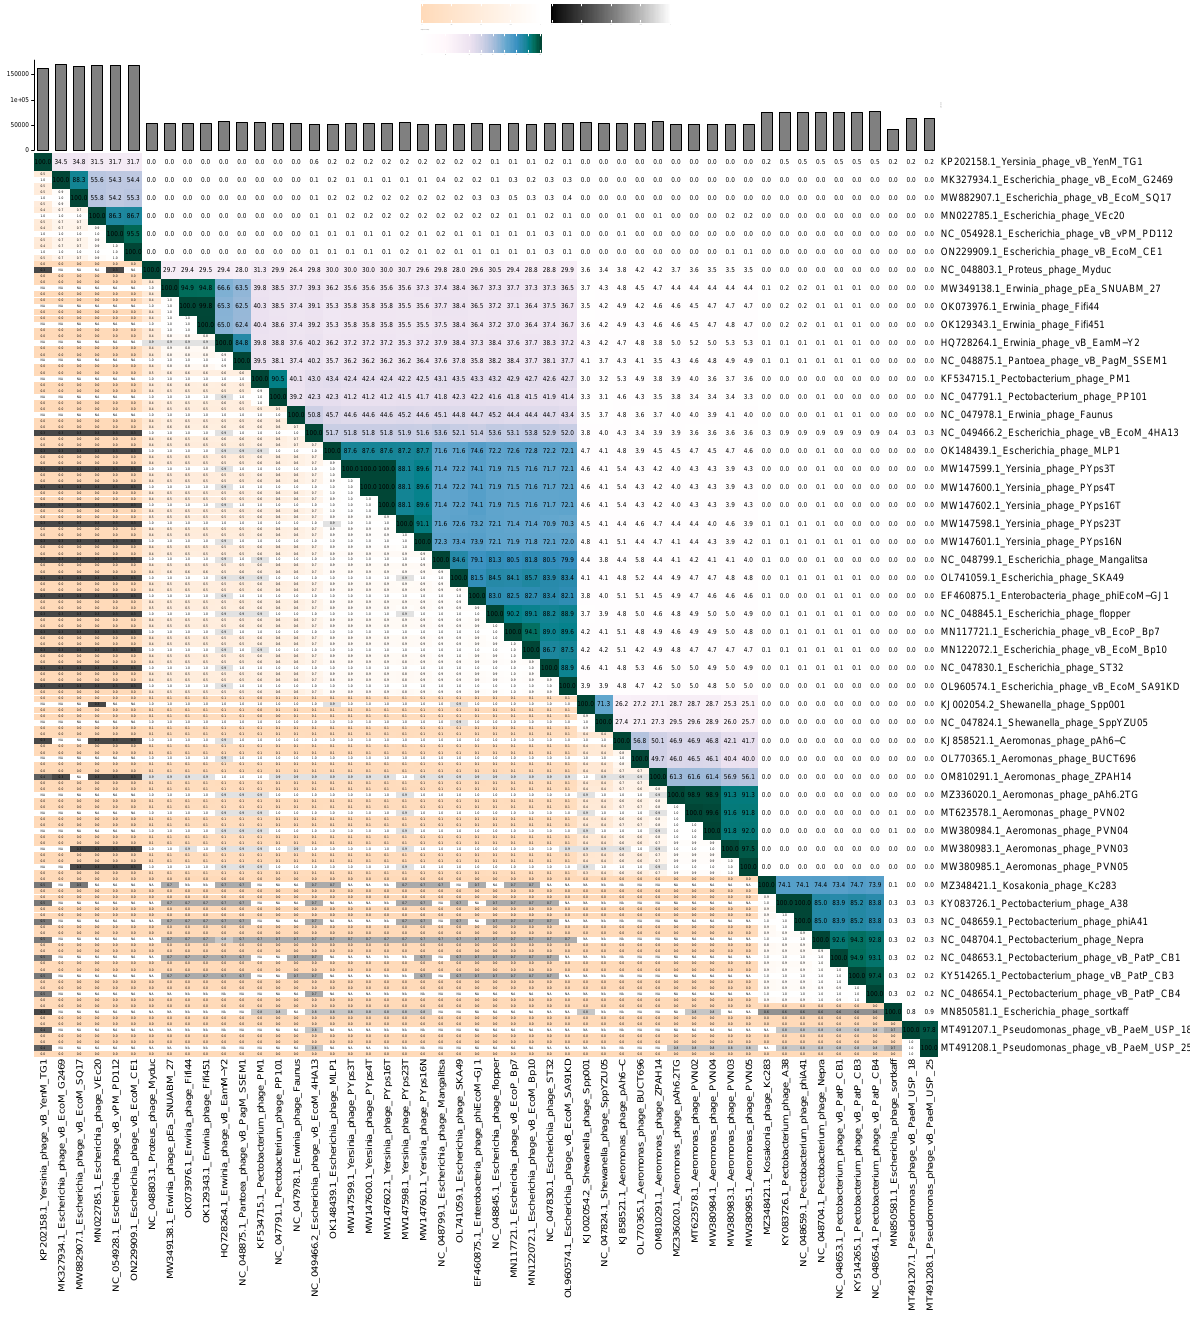
Figure 5. VIRIDIC heatmap of 4HA13 and its 50 closest nBlast homologues. The upper right half contains the intergenomic similarities between phage pairings, with intensity of color corresponding to level of similarity. The lower left half lists the percentage coverage of phage one, percentage alignment, and the percentage coverage of phage